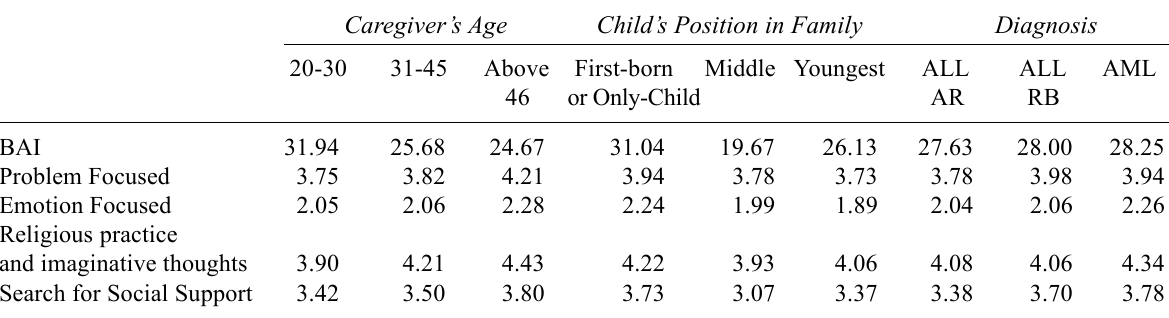
Analysis of Variance (ANOVA): Anxiety and Coping Averages, Related to Sociodemographic